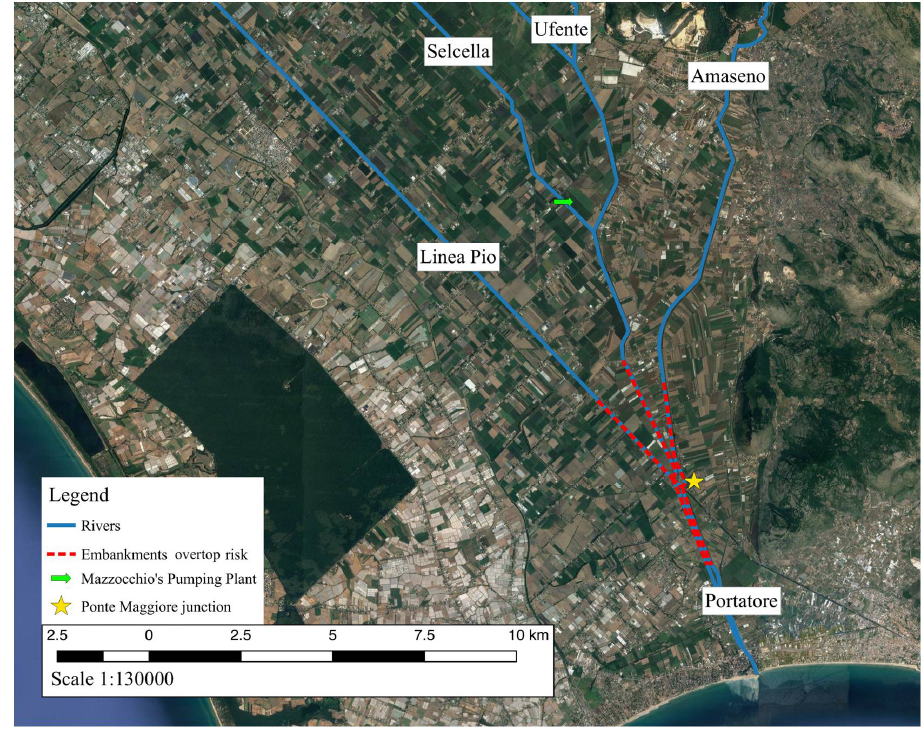
Figure 13. High risk of embankment overtop near Ponte Maggiore’s junction using a 100-year return period hyetograph as the boundary condition for the hydraulic simulation.